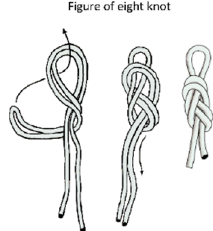
Figure 3. Knot commonly used as a terminal: Type eight.